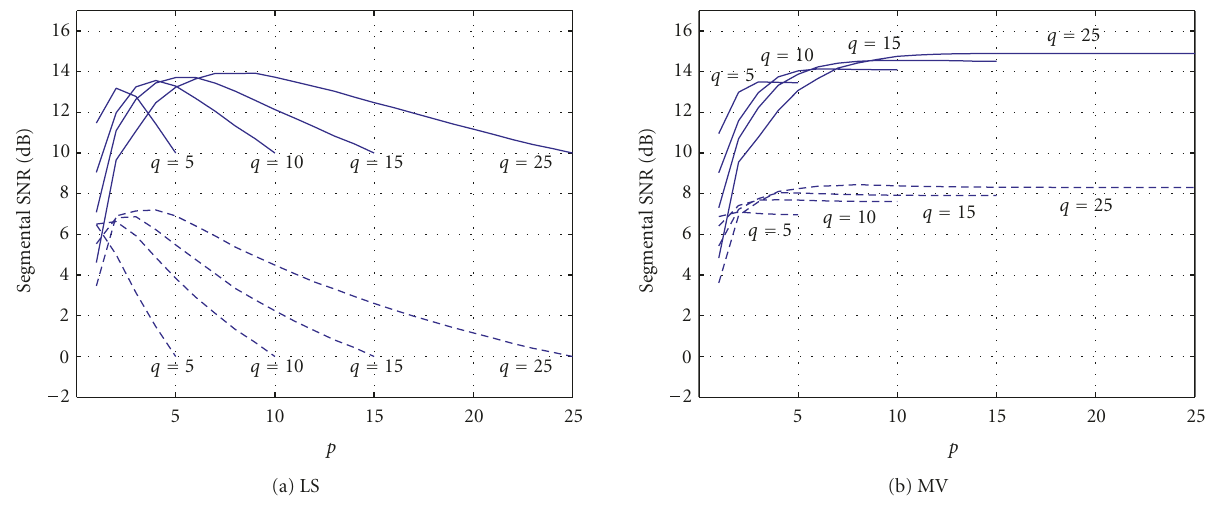
Figure 3: Segmental SNR of the enhanced signal as a function of the order p of the enhanced Hankel matrix, for di ff erent values of q . A solid line is used for noisy speech at 10 dB SNR and a dashed line for 0 dB SNR. (a) LS estimator. (b) MV estimator (representative of all estimators that perform noise reduction in the signal